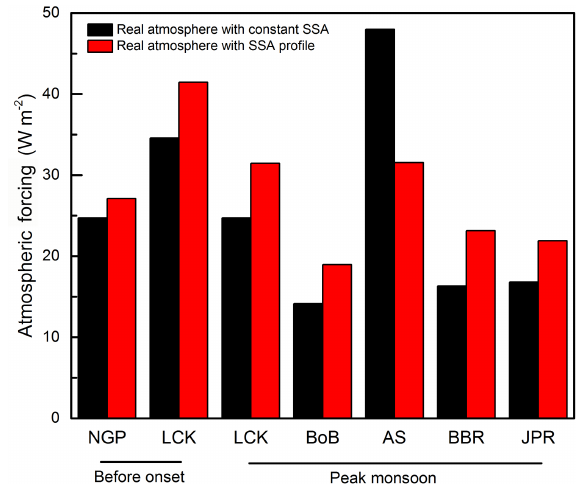
Figure 8. The instantaneous aerosol forcing for selected profiles es- timated for local noon and averaged for the locations is shown. The first two pairs of bars correspond to pre-monsoon measurements and the rest correspond to monsoon